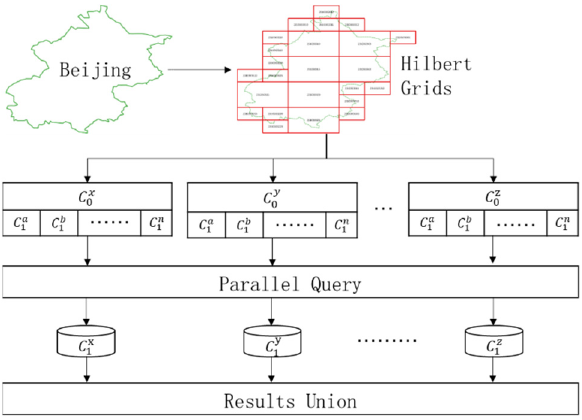
Figure 12. Remote sensing images parallel query based on Hilbert grids.